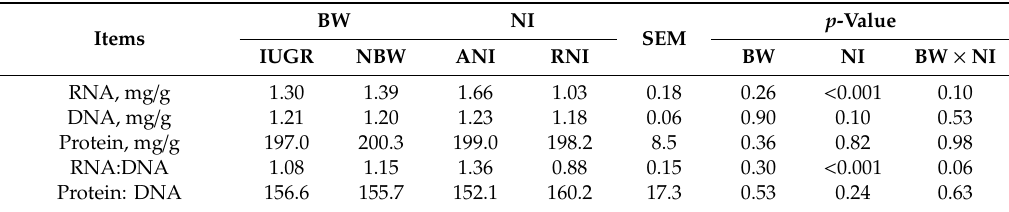
Table 6. E ff ects of the level of nutrient intake on the contents of RNA, DNA, and protein in psoas